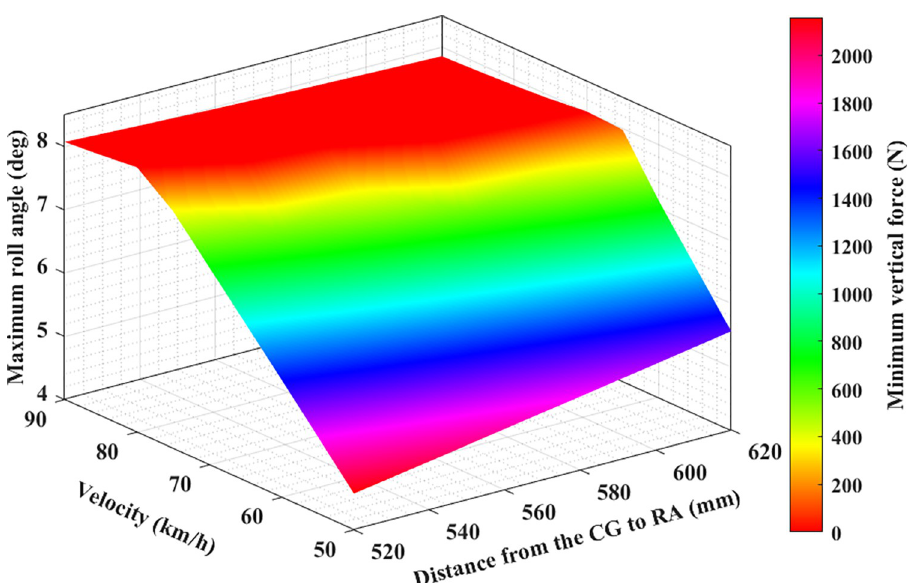
Fig 13. Limitation of rollover phenomenon (the third